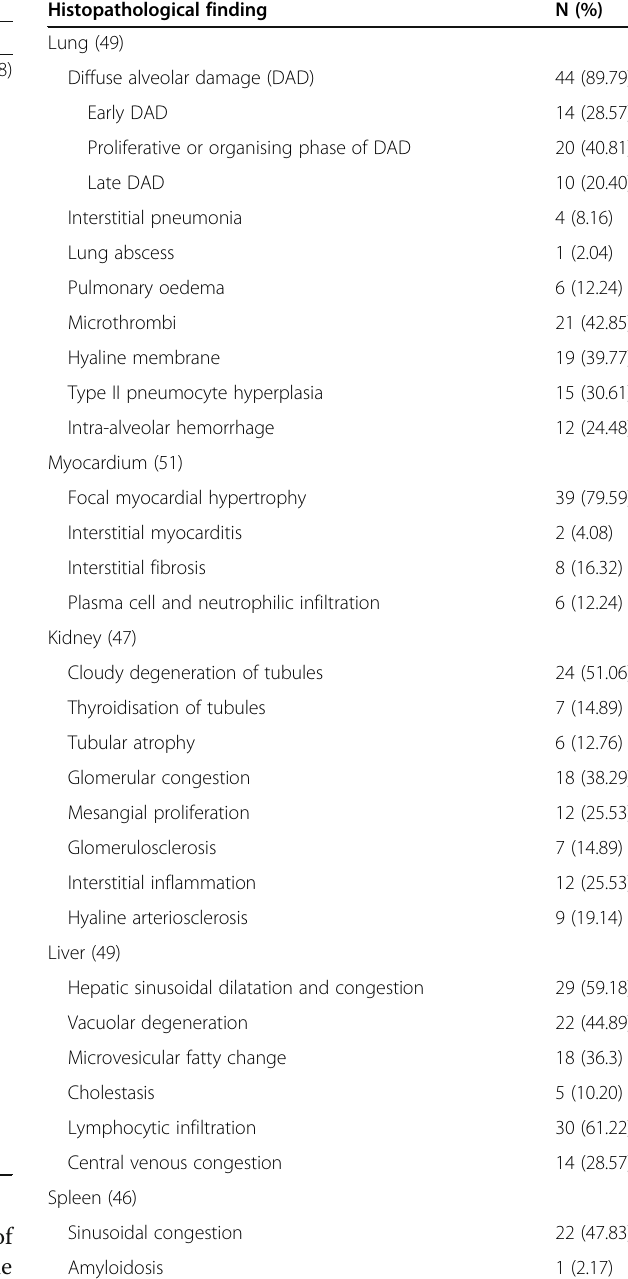
Table 1 Patient demographics, clinical parameters and cause of death noted in our MIA series